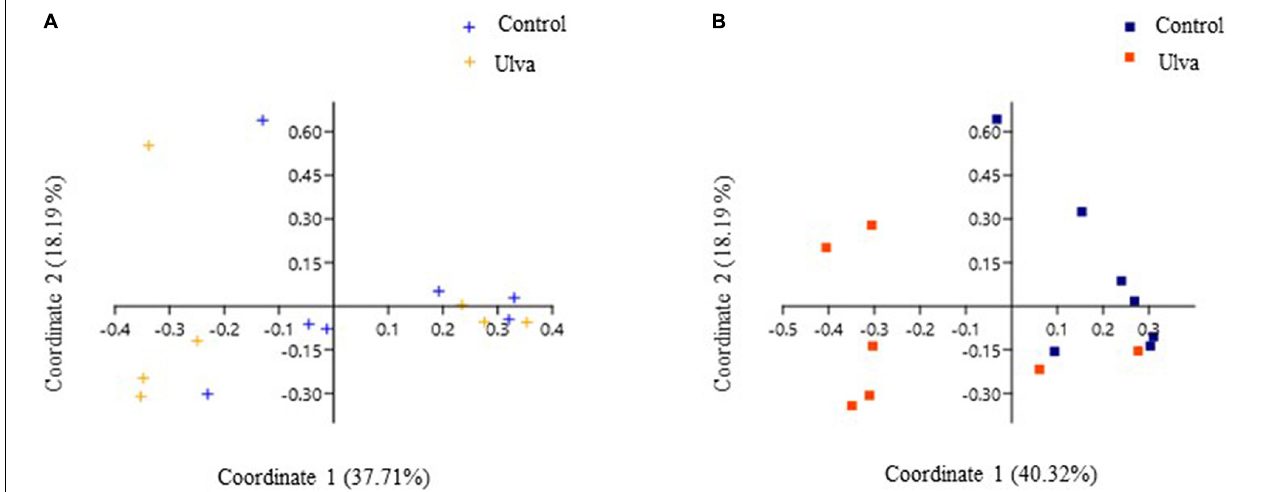
FIGURE 5 | Principal coordinate analysis (PCoA) of bacterial community composition at OTU level based on Bray–Curtis distance matrix. The individual samples are color-coordinated according to the diet received by S. senegalensis specimens: control (Control) and Ulva ohnoi supplemented (Ulva) diets for 90 days. (A) Anterior GI sections, (B) Posterior GI sections.